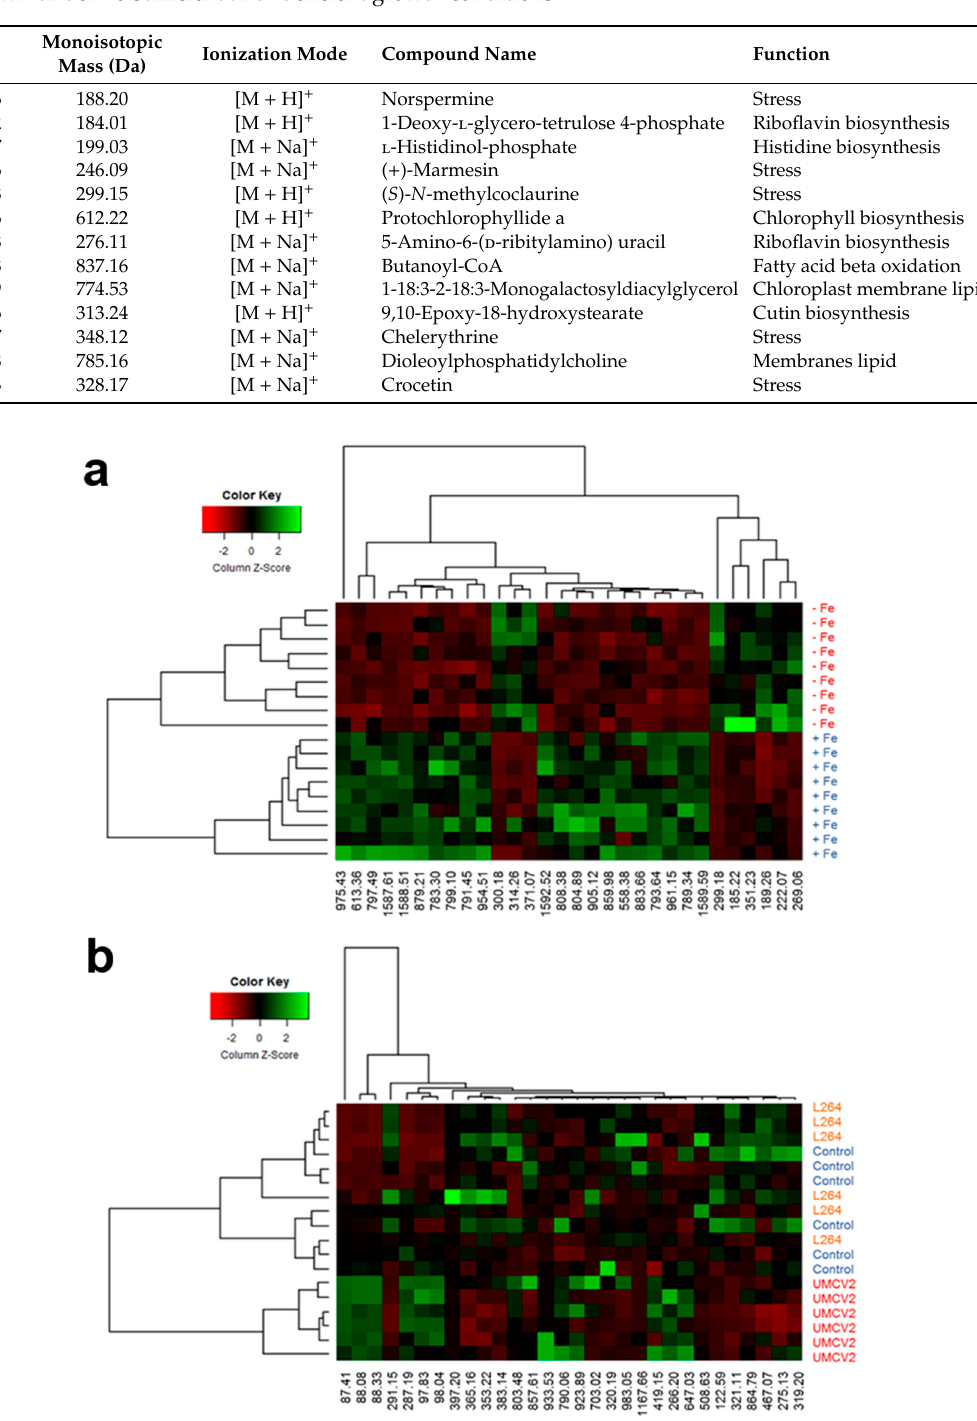
Figure 5. Metabolomic heatmap generated with the 30 most important ions detected by the Random Forest model for Fe availability ( a ) and bacterial volatiles ( b ). Heatmap combined with an analysis of cluster hierarchical using Euclidean distance between experimental units and Ward’s algorithm for classification by ion (along x-axis) and by treatment (along y -axis).